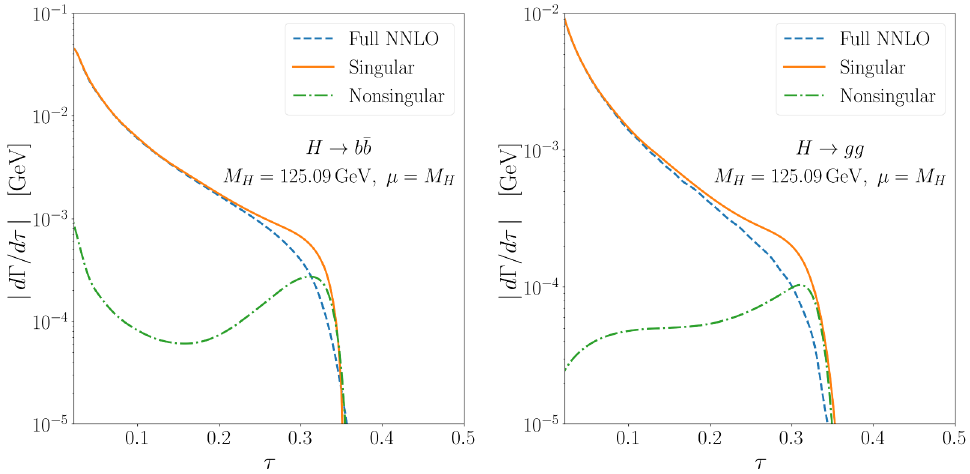
Figure 2. The full, singular and nonsingular contributions to the Higgs boson decay rate as a function of (cid:28) (cid:17) T 2 = (2 M H ) . The left panel shows the process H ! b (cid:22) b , the right shows H ! gg